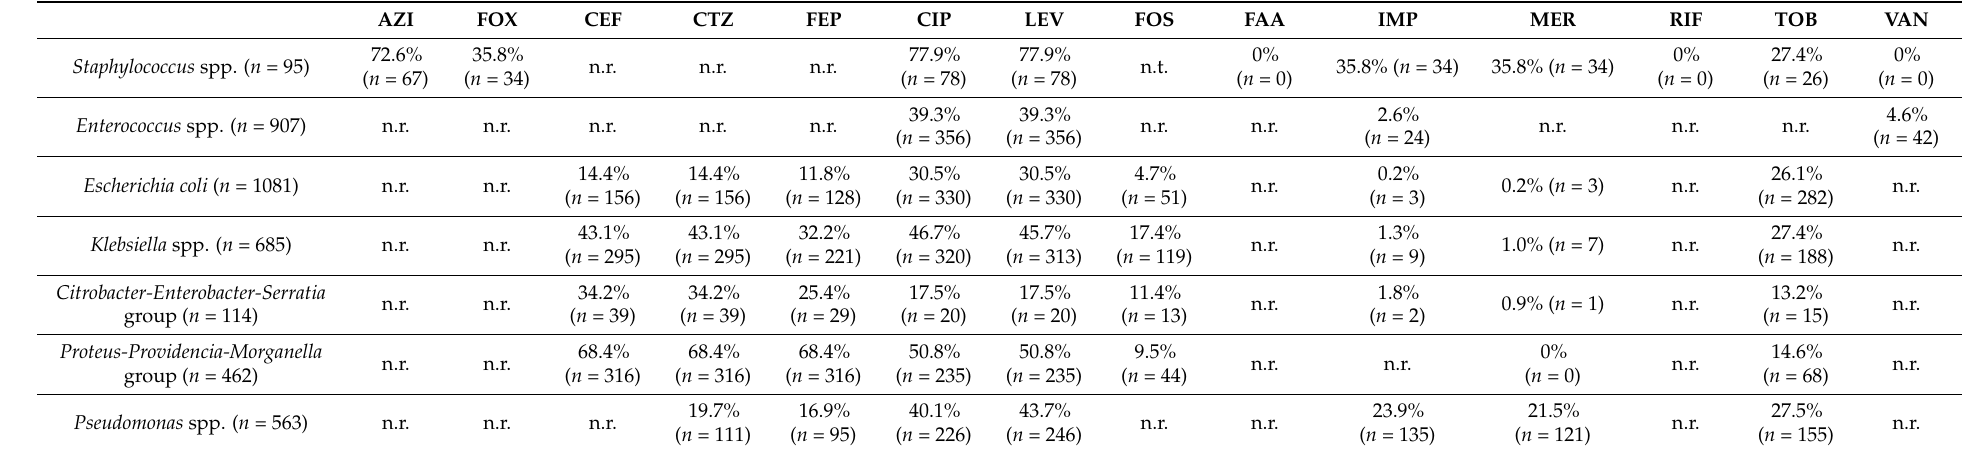
Table 7. Percentage of resistant isolates from inpatient UTIs against WHO Watch